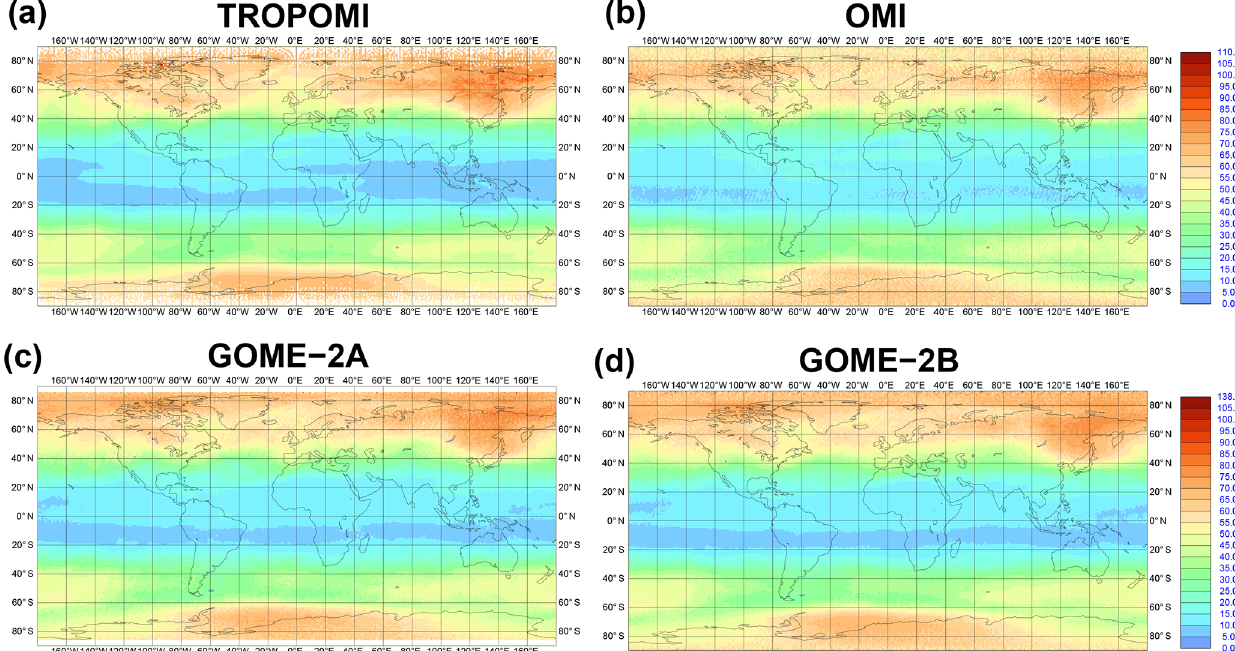
Figure 4. TCO3 standard deviation of good data for the period 26 November 2017 to 30 November 2018 from (a) TROPOMI, (b) OMI, (c) GOME-2A and (d) GOME-2B in